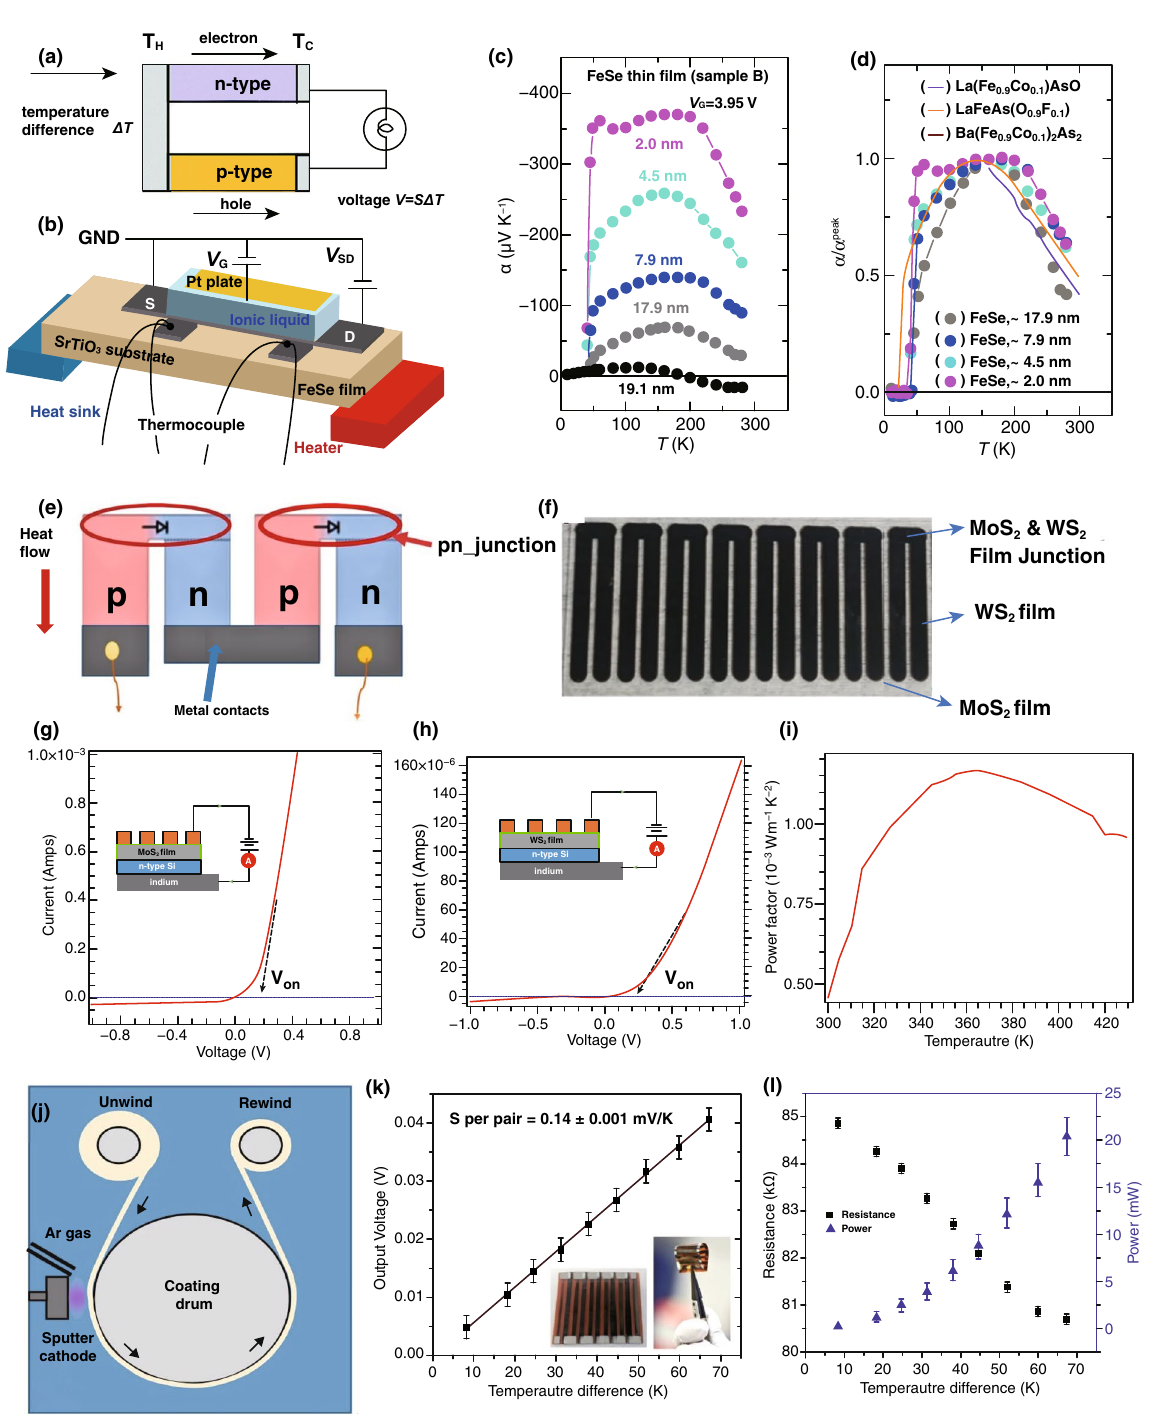
Fig. 7 Thermoelectric device structure, the working principle, and output performances of thermoelectric devices. a Mechanism of thermo- electric power generation due to Seebeck effect. b Device architecture for thermoelectric measurement. c Curve of Seebeck coefficient versus temperature. d Peak value of Seebeck coefficient according to temperature. e Thermoelectric nanogenerator based on p–n junction. f WS 2 planar film as n-leg, while depositing in the fabrication process. g Current density–voltage characteristics of MoS 2 . h Current density–voltage char- acteristics of WS 2 . i Power factor of the MoS 2 device. j Roll-to-roll arrangement for deposition on substrate. k Output voltage vs. temperature plots. l Plot of resistance and output power with changing temperature. Figures reprinted with permission from: a Ref. [101], © 2017, Royal Society of Chemistry; b , c , d Ref. [102], © 2019 Nature; e , f , g , h , i Ref. [103], © 2020 Nature; j , k , l Ref. [87], © 2019